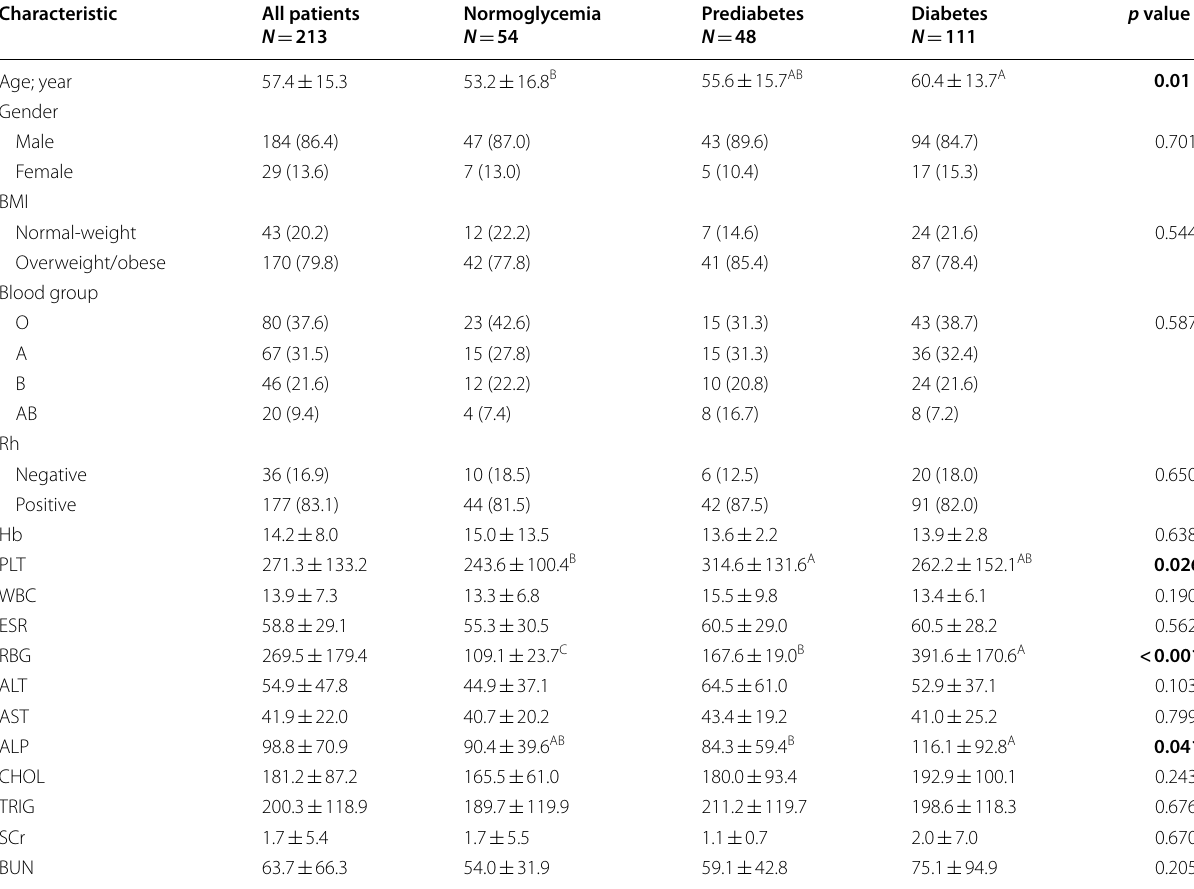
Table 1 Characteristics of COVID‑19